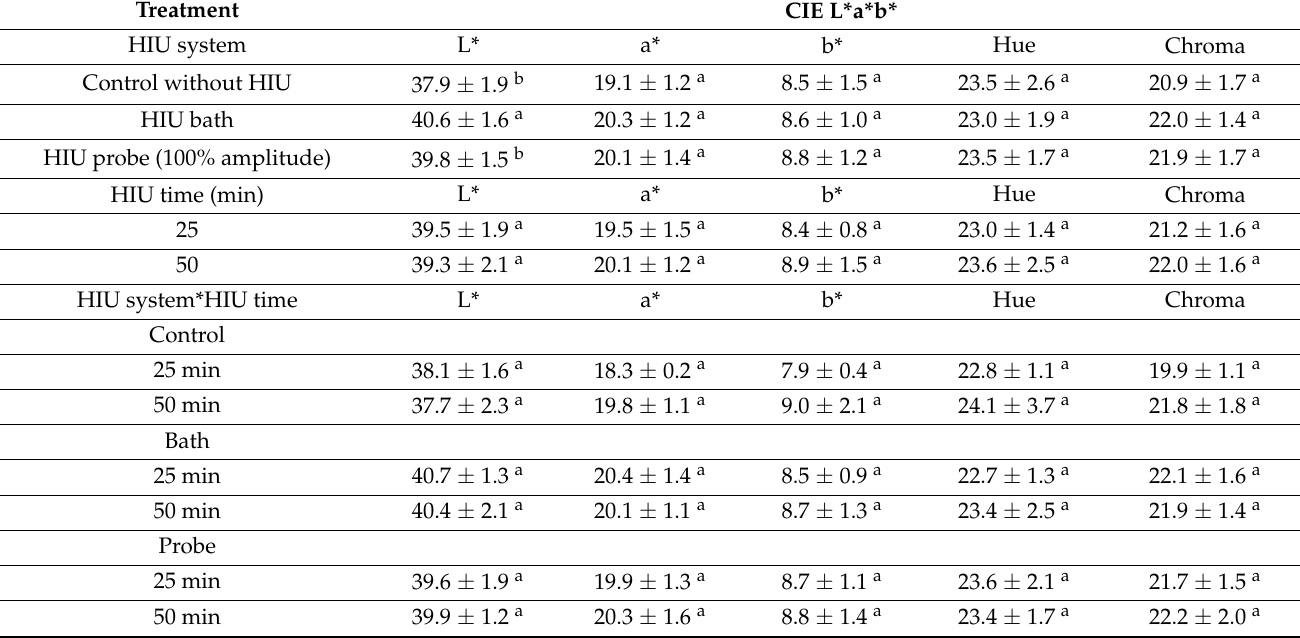
Table 1. Effect of the HIU system, HIU time, and the combination between them, on color parameters L*, a*, b*, tone (Hue), and chroma of bovine Longissimus lumborum